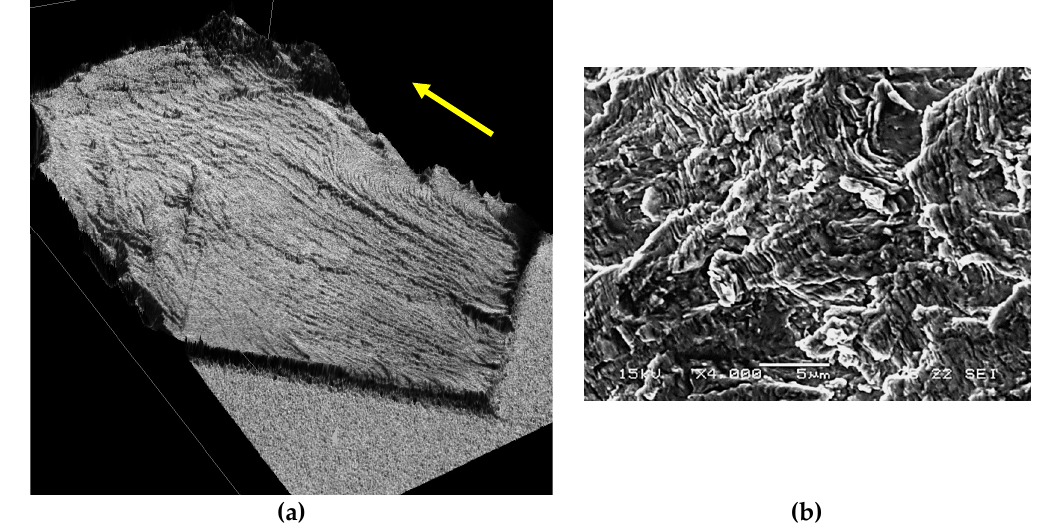
Figure 11. Fatigue fracture modes in the [100] crystallographic orientation: ( a ) macroscopic view observed by confocal microscope; ( b ) well developed fatigue striations, observed by SEM. The yellow arrow indicates the direction of fatigue crack propagation.